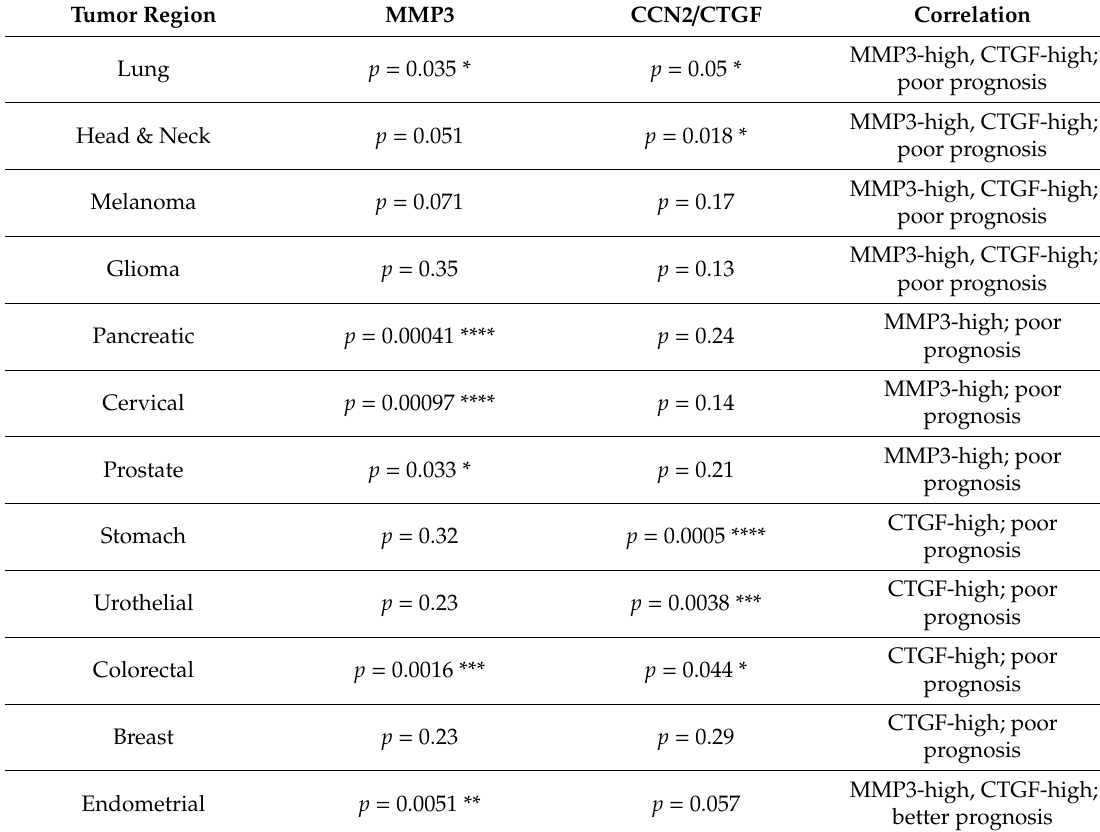
Table 4. MMP3 and / or CCN2 / CTGF expression correlated with the prognosis of cancer patients. Tumor Region